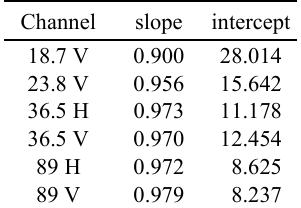
Table 1. The regression coefficients of yearly models for bias